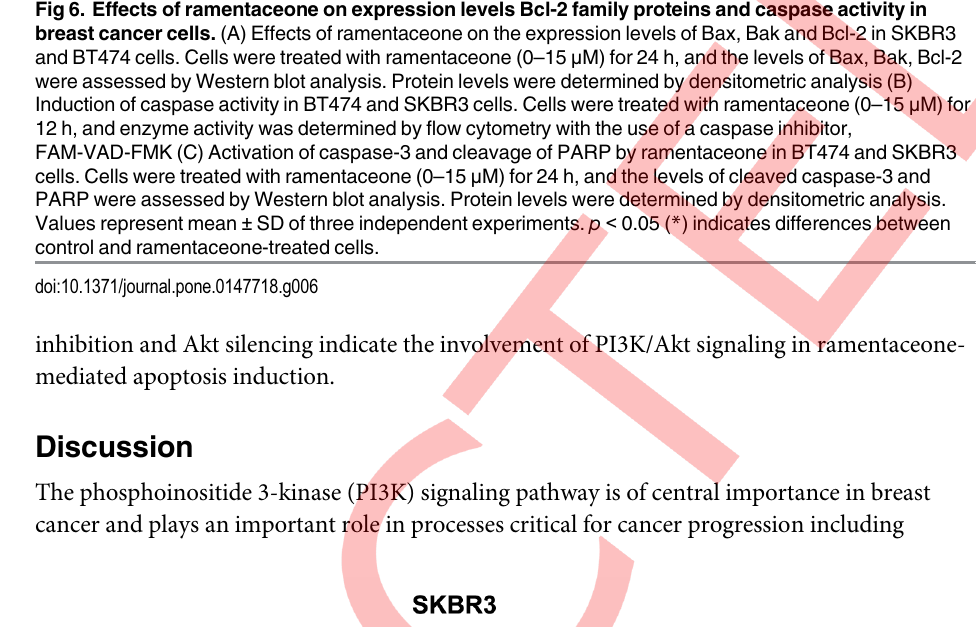
Fig 6. Effects of ramentaceone on expression levels Bcl-2 family proteins and caspase activity in breast cancer cells. (A) Effects of ramentaceone on the expression levels of Bax, Bak and Bcl-2 in SKBR3 and BT474 cells. Cells were treated with ramentaceone (0 – 15 μ M) for 24 h, and the levels of Bax, Bak, Bcl-2 were assessed by Western blot analysis. Protein levels were determined by densitometric analysis (B) Induction of caspase activity in BT474 and SKBR3 cells. Cells were treated with ramentaceone (0 – 15 μ M) for 12 h, and enzyme activity was determined by flow cytometry with the use of a caspase inhibitor, FAM-VAD-FMK (C) Activation of caspase-3 and cleavage of PARP by ramentaceone in BT474 and SKBR3 cells. Cells were treated with ramentaceone (0 – 15 μ M) for 24 h, and the levels of cleaved caspase-3 and PARP were assessed by Western blot analysis. Protein levels were determined by densitometric analysis. Values represent mean ± SD of three independent experiments. p < 0.05 ( * ) indicates differences between control and ramentaceone-treated cells.